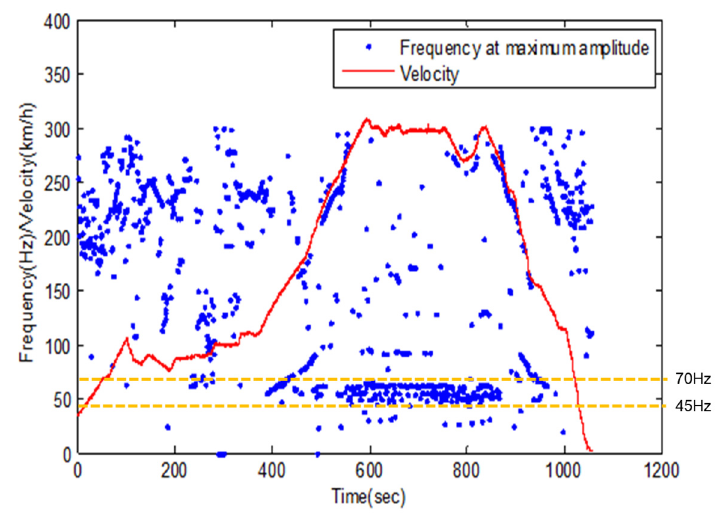
Figure 17. The fast fourier transform (FFT) results and velocity data, the resonant frequency occurred mainly when the frequency was 50 Hz during 300 km/h driving, however, the primary frequency band was between 45 and 70 Hz.